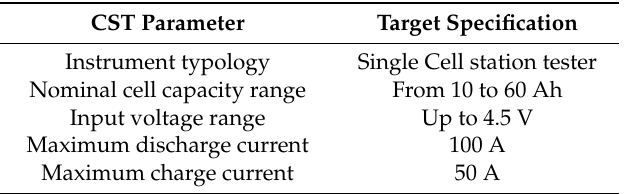
Table 2. Proposed cell station tester design